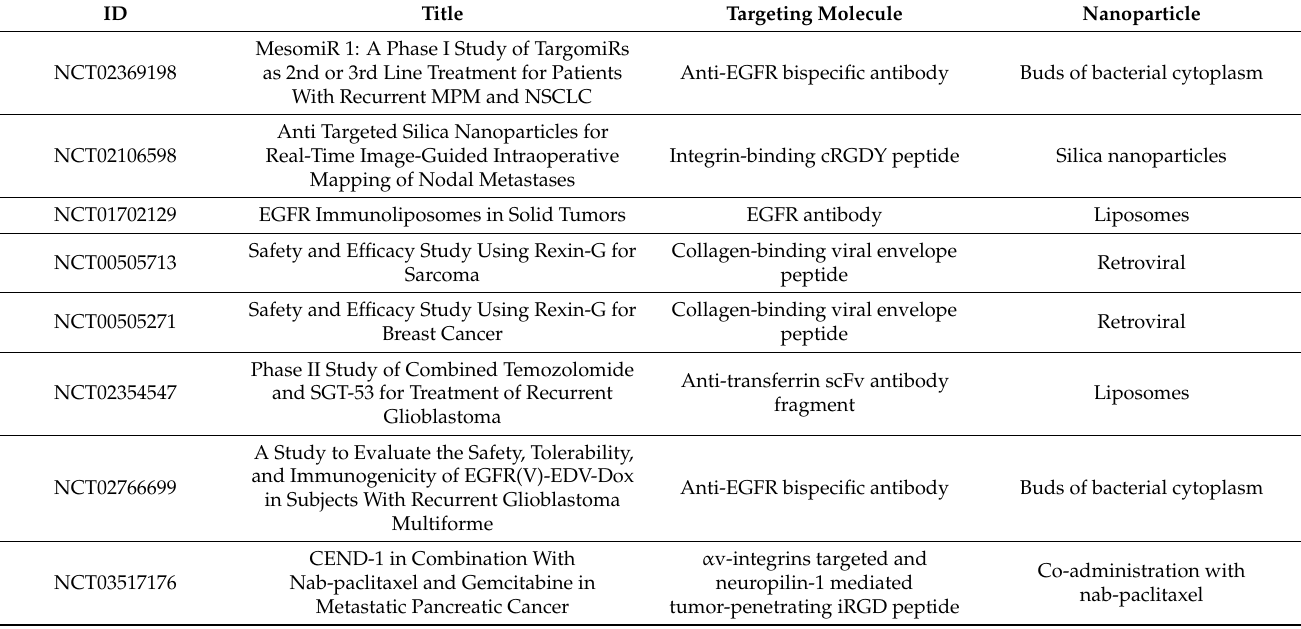
Table 1. Active targeting strategies currently in the clinical trials (https://clinicaltrials.gov, accessed on 25 November 2020).